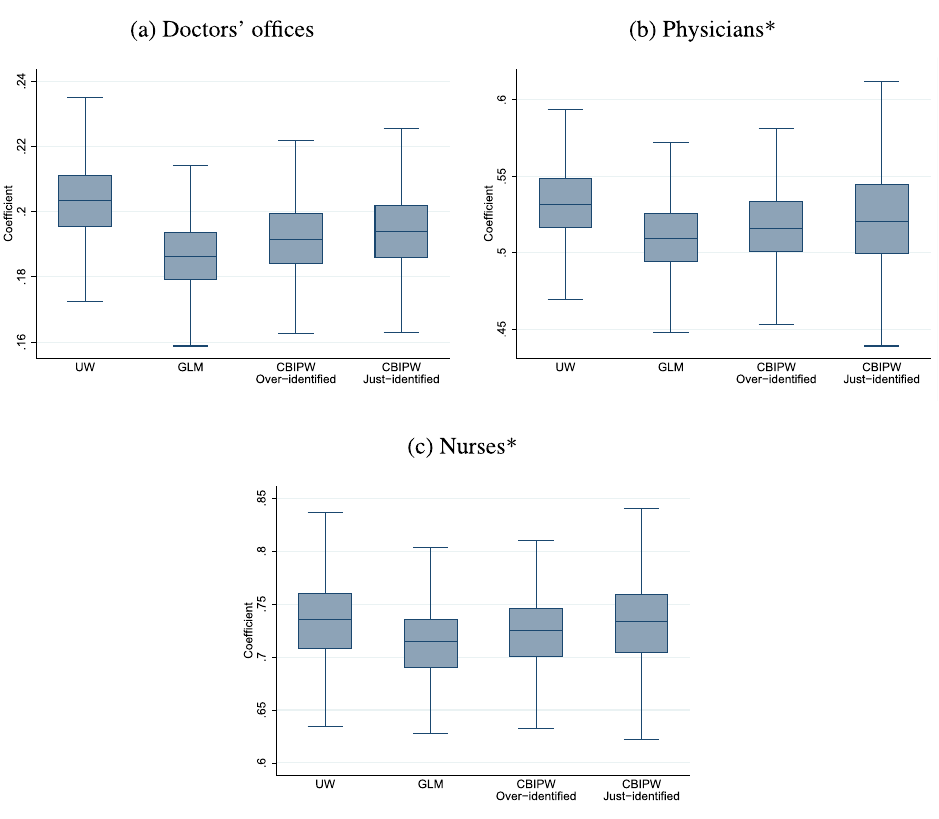
Figure 3: Average Treatment Effects of SP coverage on Sanitary